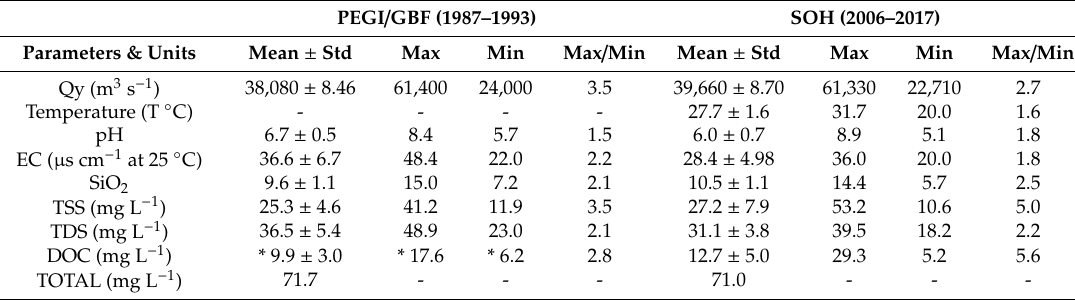
Figure 3. ( a ) Evolution of monthly river discharge related to the two studied periods and the interannual period (1903–2017). ( b ) Interannual variation of annual Congo River discharges (period 1903–2017). Table 1. Interannual yearly discharge (Qy) and surface water quality parameters (temperature, pH, electrical conductivity, SiO 2 , total dissolved solid (TDS) concentrations, dissolved organic carbon (DOC) concentrations, total suspended solid (TSS) concentrations, and total matter (TOTAL = TDS + DOC + TSS) for the Congo River Outlet, calculated for the two studied periods (1987–1993 and